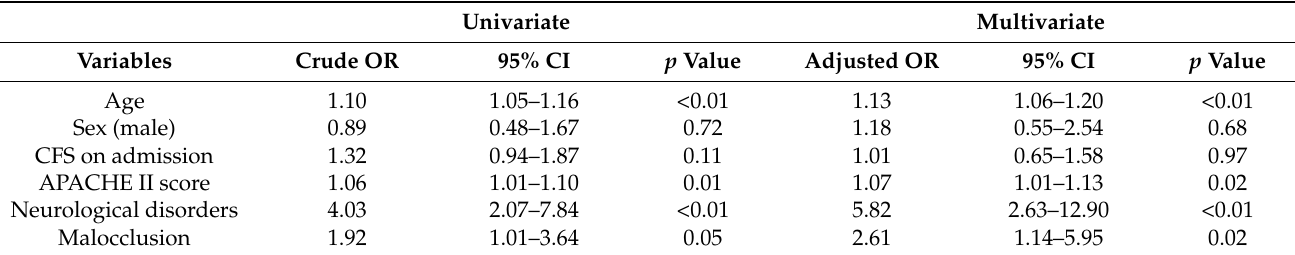
Table 6. Univariate and Multivariate analysis for Delirium of the study population 65 years and older. Univariate